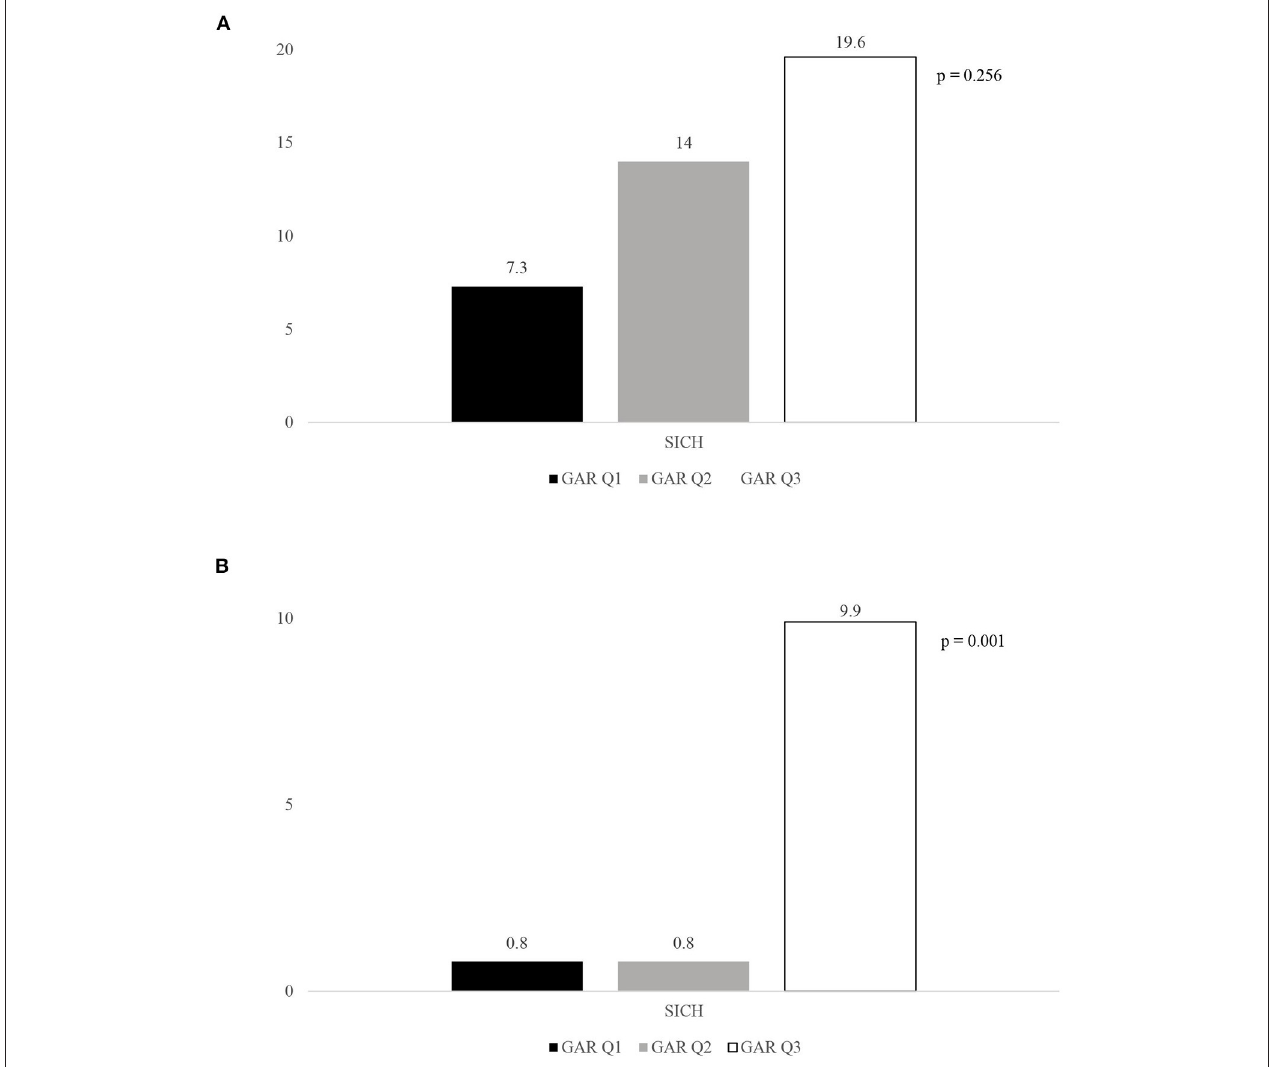
FIGURE 4 | Rates of SICH according to the GAR tertiles in diabetic. (A) and non-diabetic patients (B) . GAR Q1, first glucose-to-glycated hemoglobin ratio tertile; GAR Q2, second glucose-to-glycated hemoglobin ratio tertile; GAR Q3, third glucose-to-glycated hemoglobin ratio tertile; SICH, symptomatic intracranial